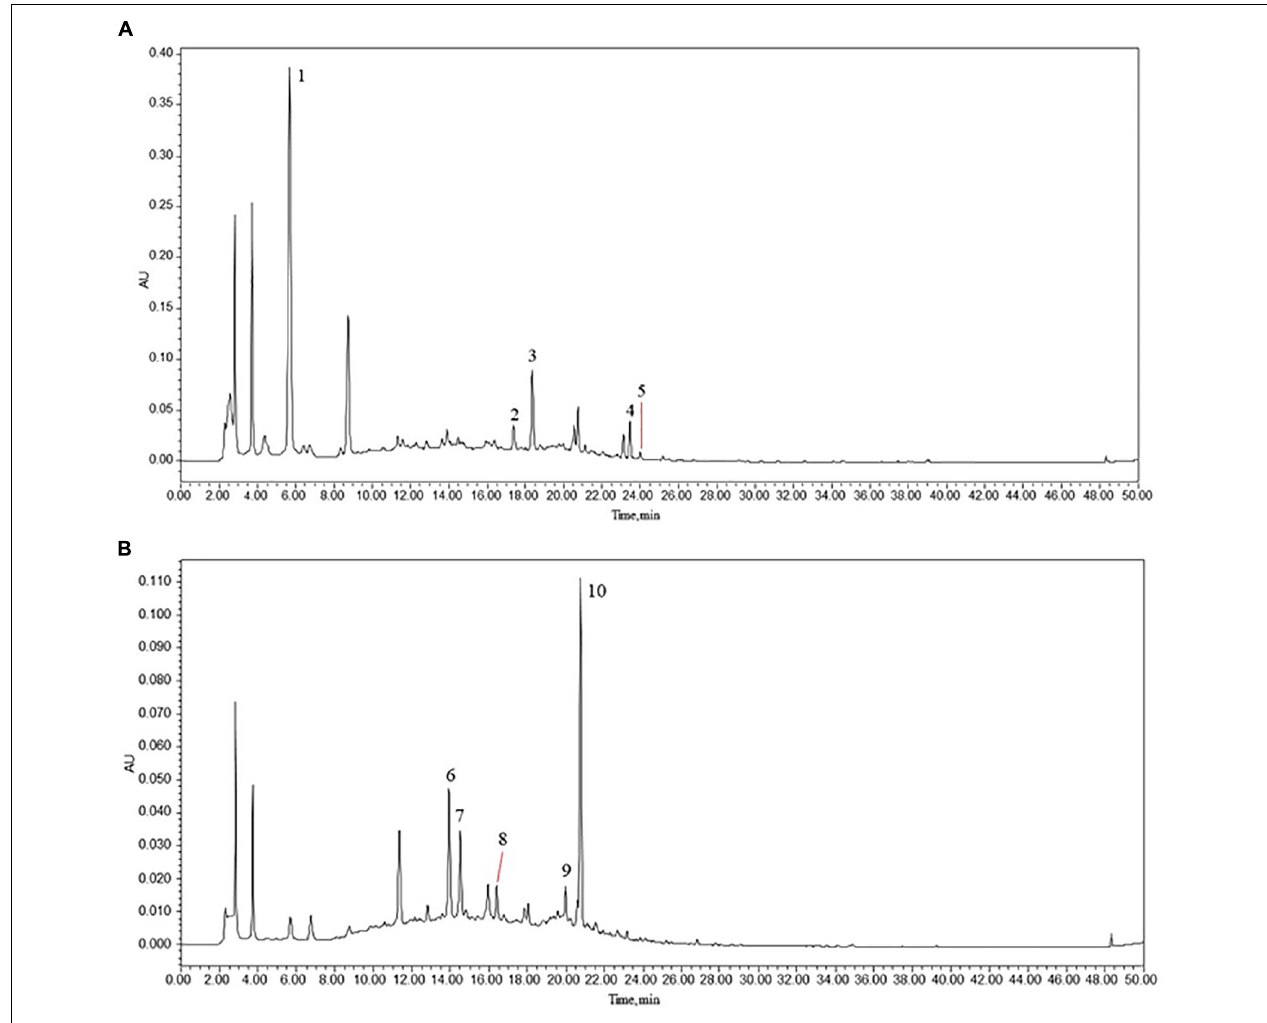
FIGURE 1 | (1) Gallic acid, (2) albiflorin, (3) paeoniflorin, (4) senkyunolide I, (5) ligustilide, (6) oxypaeoniflorin, (7) catechin, (8) caffeic acid, (9) verbascoside, and (10) chlorogenic acid. HPLC-DAD chromatograms of various constituents in EJSW. (A) 276 nm. (B) 234 nm.